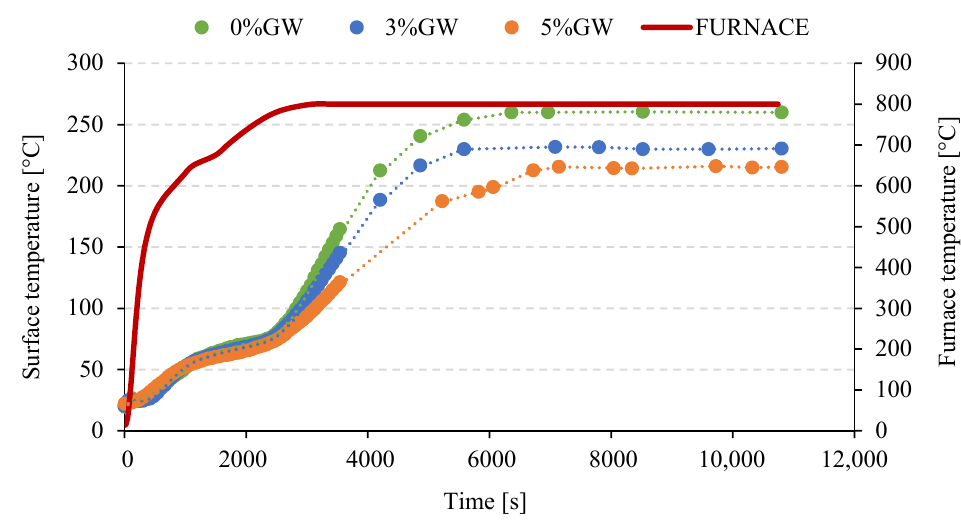
Figure 10. Temperature change depending on the heating time and the glass wool waste content.